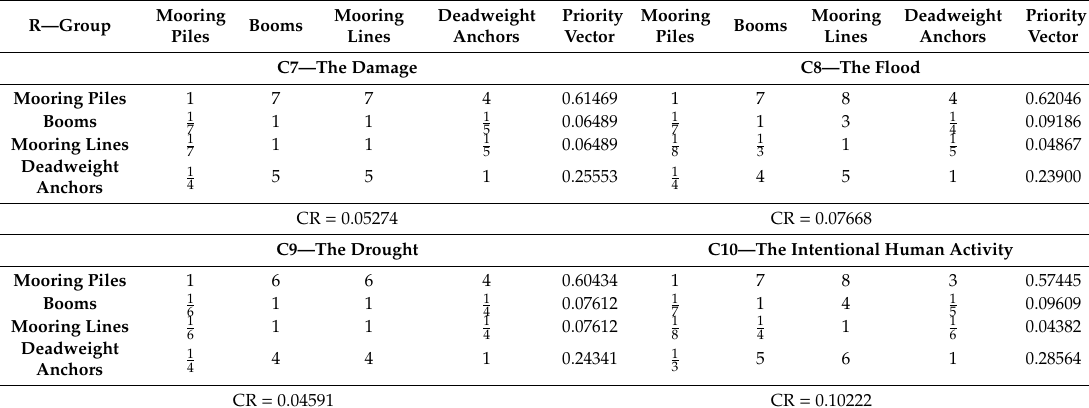
Table 10. Comparison matrix alternative for External risk factors criteria